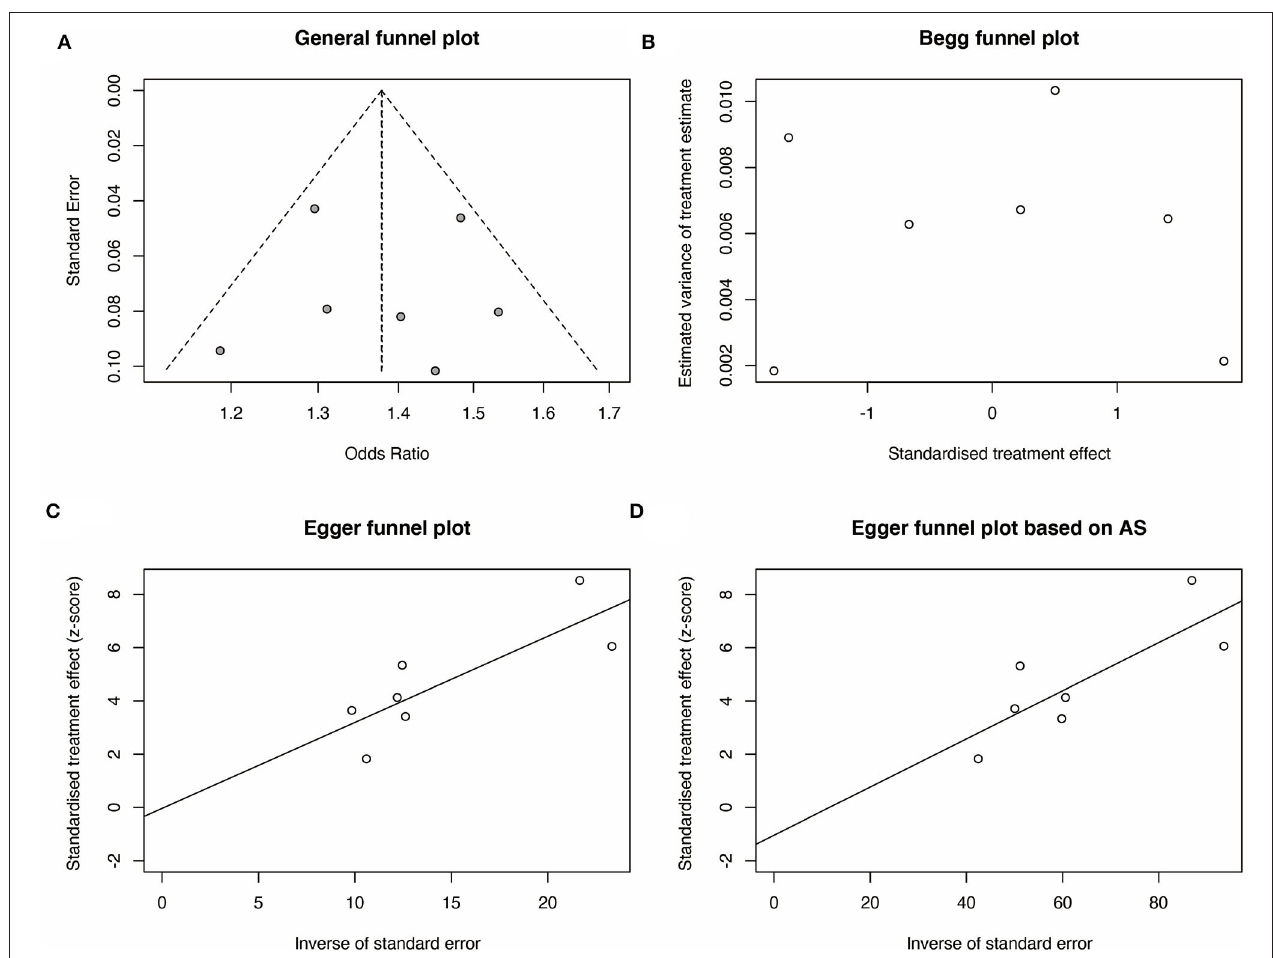
FIGURE 4 | Publication bias analysis for rs2439302 polymorphism and the TC risk for G vs. C (allele model). (A) A funnel plot of publication bias analysis was performed to explore the correlation between rs2439302 polymorphism and TC risk. The methods based on linear regression proposed by (B) Begg plot and (C) Egger test were used to evaluate the asymmetry of the funnel plot. (D) The method based on linear regression proposed by the Egger test based on arcsine difference was utilized to analyze the asymmetry of the funnel